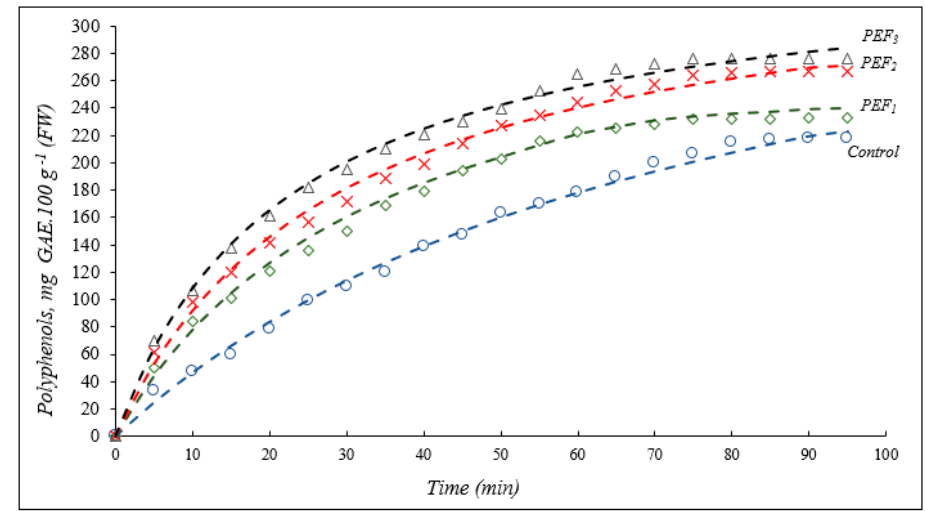
Figure 4. Effect of different treatments of PEF (PEF 1 = 1 KV.cm − 1 , PEF 2 = 2 KV.cm − 1 , and PEF 3 = 2.5 KV.cm − 1 ) on the polyphenolics extraction during diffusion at 50 °C (Each experiment was repeated three times).